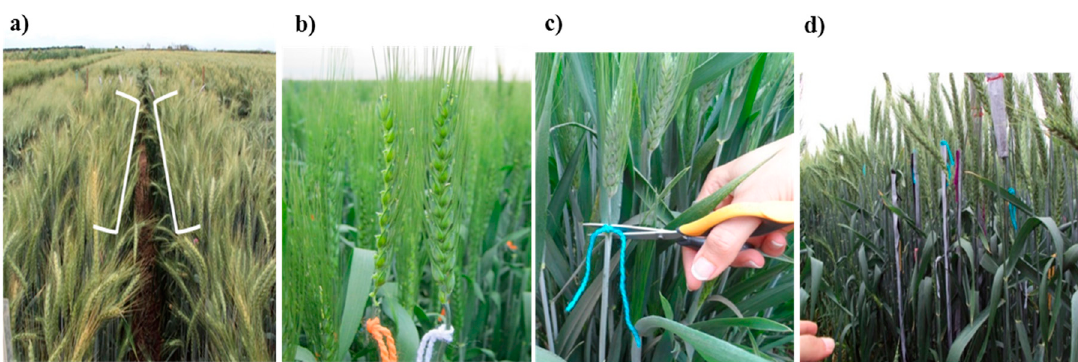
Figure 1. Source and sink manipulation treatments: ( a ) plot area designated for manipulation treatments; ( b ) de-grained and control spike; ( c ) defoliation (DEF) and ( d ) stem and leaf sheath covered with textile (StemCOV); all treatments applied at anthesis +10 days (GS65+10d).